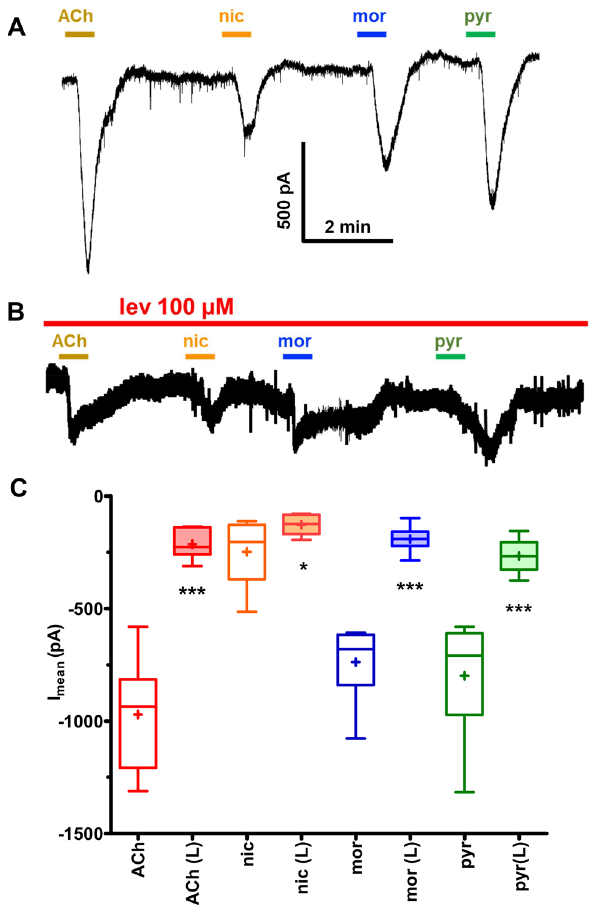
Figure 5. B. malayi whole worms after long term whole worm levamisole exposure loses agonist sensitivity in muscles under patch-clamp. ( A ) Representative single electrode patch-clamp recording from muscle cells of control B. malayi with no prior levamisole exposure demonstrating inward current produced by different nicotinic agonists (ACh, pyrantel, nicotine, and morantel) each at 30 µM concentration for 30 s. ( B ) Representative single electrode patch-clamp recording from B. malayi muscle cells after 4 h 100 µM levamisole exposure shows reduction inward currents to different nicotinic agonists (ACh, pyrantel, nicotine and morantel) each at 30 µM concentration for 30 s in the presence of 100 µM levamisole . ( C ) Bar chart demonstrating comparative inward currents in muscle cells treated with 30 µM ACh, pyrantel, nicotine and morantel in: